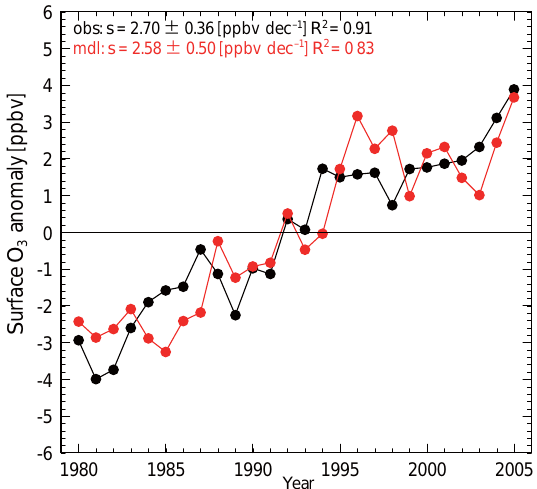
Figure 3. The temporal changes in annual mean surface O 3 anomaly averaged over Japan from observation (AEROS: black) and model calculations (red). Anomalies are defined as deviations from the values averaged over 1980–2005. The slope of a regression ( s ) for 1980–2005 with its 95% confidence interval and R 2 are also